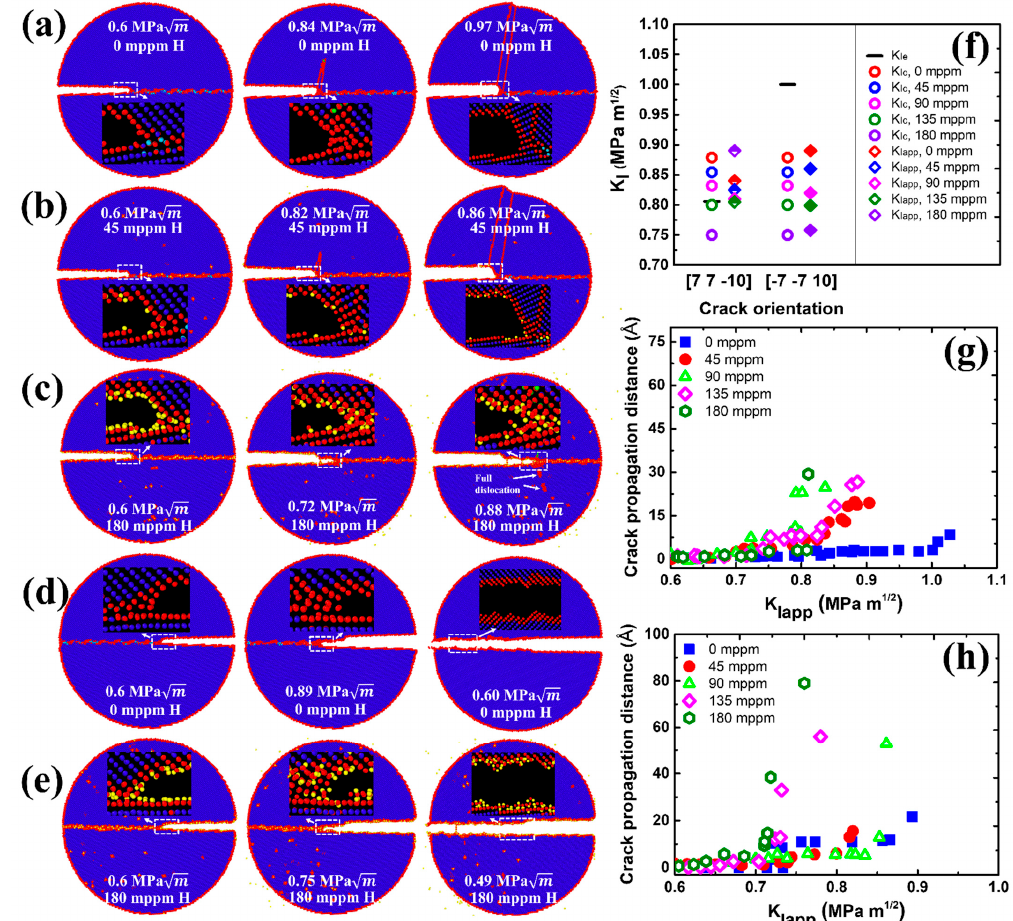
Figure 4. MD snapshots illustrating the crack propagation in the simulations of Σ 11 (5 5 7) A ( 7(cid:3364) 7(cid:3364) 1) B GB along ( a ) [ 7 7 10(cid:3364)(cid:3364)(cid:3364)(cid:3364) ] direction with 0 mppm H atoms, ( b ) [ 7 7 10(cid:3364)(cid:3364)(cid:3364)(cid:3364) ] direction with 45 mppm H atoms, ( c ) [ 7 7 10(cid:3364)(cid:3364)(cid:3364)(cid:3364) ] direction with 180 mppm H atoms, ( d ) [ 7(cid:3364) 7(cid:3364) 10 ] direction with 0 mppm H atoms, and ( e ) [ 7(cid:3364) 7(cid:3364) 10 ] direction with 180 mppm H atoms. ( f ) Overview of critical stress intensity factors 𝐾 (cid:3010)(cid:3032) and 𝐾 (cid:3010)(cid:3030) , and the global applied stress intensity factor 𝐾 (cid:3010)(cid:3028)(cid:3043)(cid:3043) in dependence on crack orientation and H concentration. The partially filled diamonds indicate ductile emission, while solid diamonds indicate the brittle cleavage. Crack propagation distance versus the stress intensity 𝐾 (cid:3010)(cid:3028)(cid:3043)(cid:3043) with various H concentrations along ( g ) [ 7 7 10(cid:3364)(cid:3364)(cid:3364)(cid:3364) ] direction and ( h ) [ 7(cid:3364) 7(cid:3364) 10 ] direction.